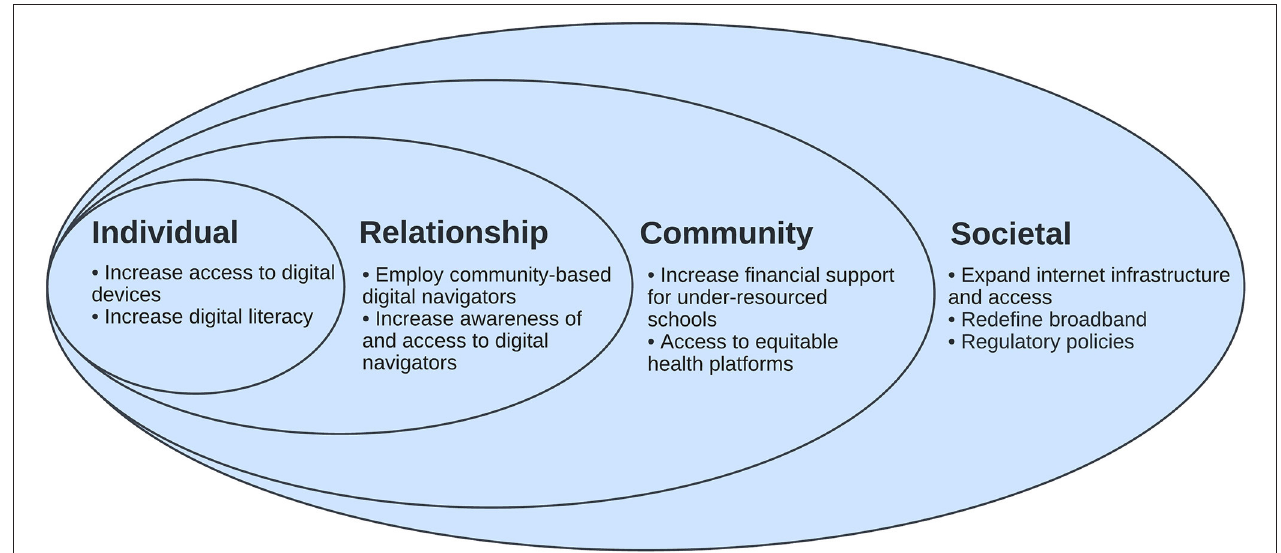
FIGURE 1 | Socio-Ecological Model for Addressing Digital